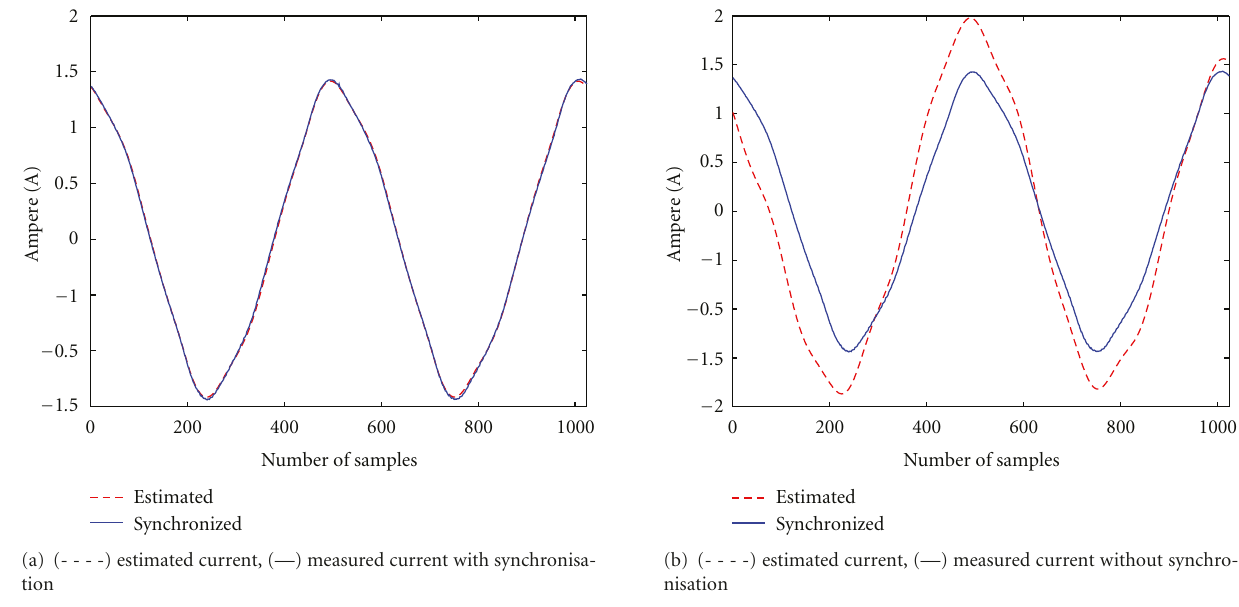
Figure 18: Superposition of two currents.